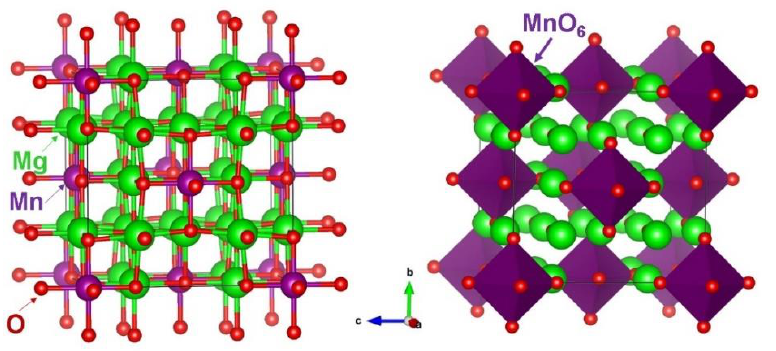
Figure 1. Crystallographic structure of Mg 6 MnO 8 (space group 𝐹𝑚3̅𝑚 ). Table 1. Comparison between the experimental and calculated structural parameters of cubic (𝐹𝑚3̅𝑚) Mg 6 MnO 8 .